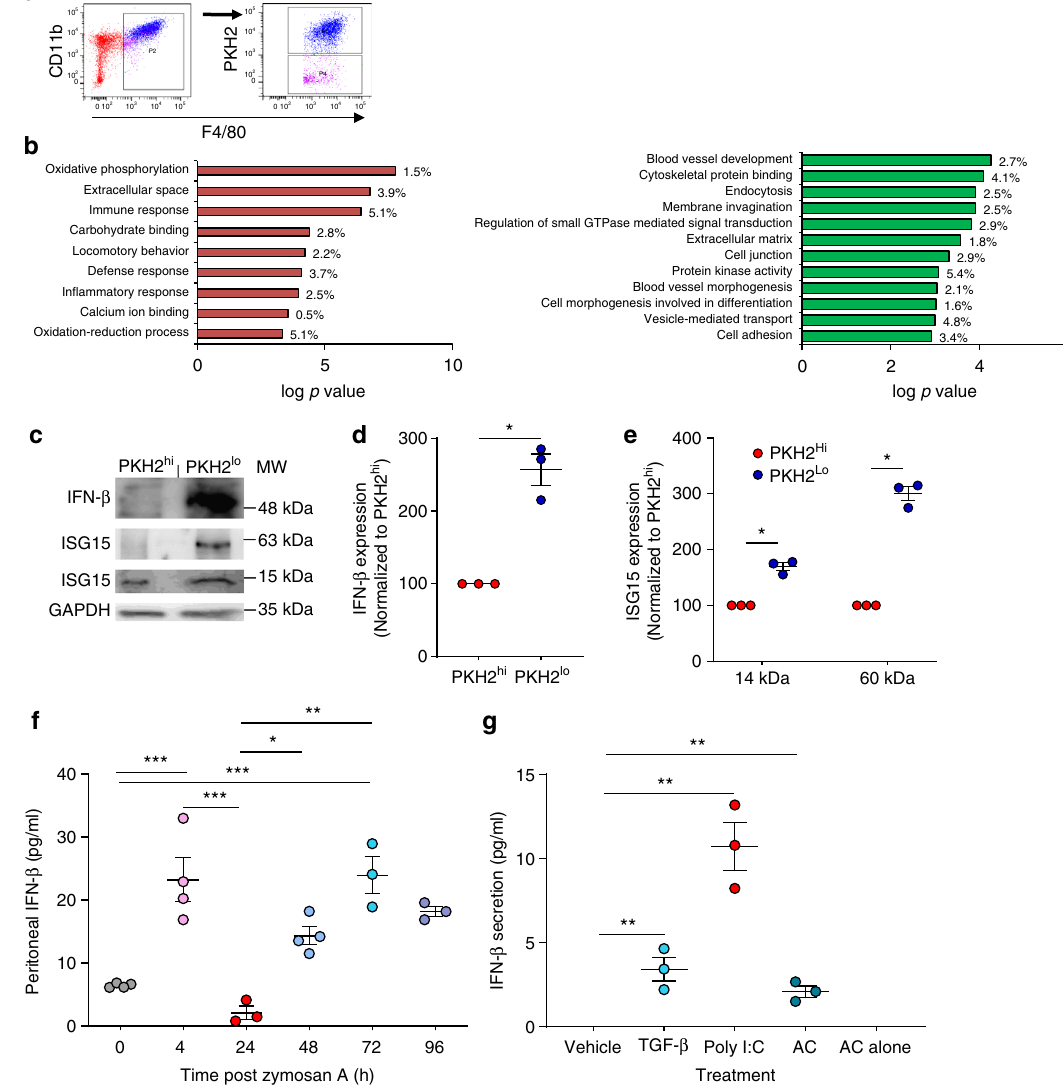
Fig. 1 Non-phagocytic resolution phase macrophages express IFN- β . a , b Male mice were injected intraperitoneally with zymosan A (1 mg/mouse) followed by an injection of PKH2-PCL at 62 h. After 4 h, the peritoneal cells were recovered and immuno-stained for F4/80 and CD11b. Then, F4/80 + macrophages were sorted based on the extent of PKH2-PCL acquisition (PKH2 + / − populations; >98% purity) using the FACSAria III sorter (illustrated in ( a ). The collected cells were immediately used for RNA extraction (with RNA integrity value above 7.5), and a gene expression microarray analysis was performed using Illumina hiSeq 2500. Differential gene expression analysis and gene ontology (GO) enrichment were performed for genes that were signi fi cantly upregulated ( b , left panel) or downregulated ( b , right panel) in non-phagocytic/satiated (PKH2-PCL lo ) macrophages in comparison to phagocytic (PKH2- PCL hi ) ones. The results indicate the statistical signi fi cance of the GO term and the percentage of enrichment is presented. c – e Expression of IFN- β and ISG15 in sorted satiated and phagocytic macrophages. Representative results ( c ) and mean ± SEM ( d , e ) for three independent experiments. * P < 0.05 (Student ’ s t test). g , h Peritoneal exudates were collected from unchallenged mice (0 h) or following peritonitis for 4 – 96 h. IFN- β content in cell-free fl uids was determined by ELISA ( f ). Results are mean ± SEM from three (24, 72, 96 h) or four (0, 4, 48 h) mice. * P < 0.05, ** P < 0.01, *** P < 0.005 (Tukey ’ s HSD). Alternatively, resolution phase macrophages were recovered 66 h post peritonitis initiation (PPI) and incubated with TGF- β (5 ng/ml), poly (I:C) (4 μ g/ml) or apoptotic cells (AC, at a ratio of 1:5) for 24h. Culture supernatants were then collected and IFN- β content was measured ( g ). Culture media from apoptotic cells served as control. Results are representative from three independent experiments. * P < 0.05, ** P < 0.01, *** P < 0.005 (Tukey ’ s HSD). Source data are provided as a Source Data fi